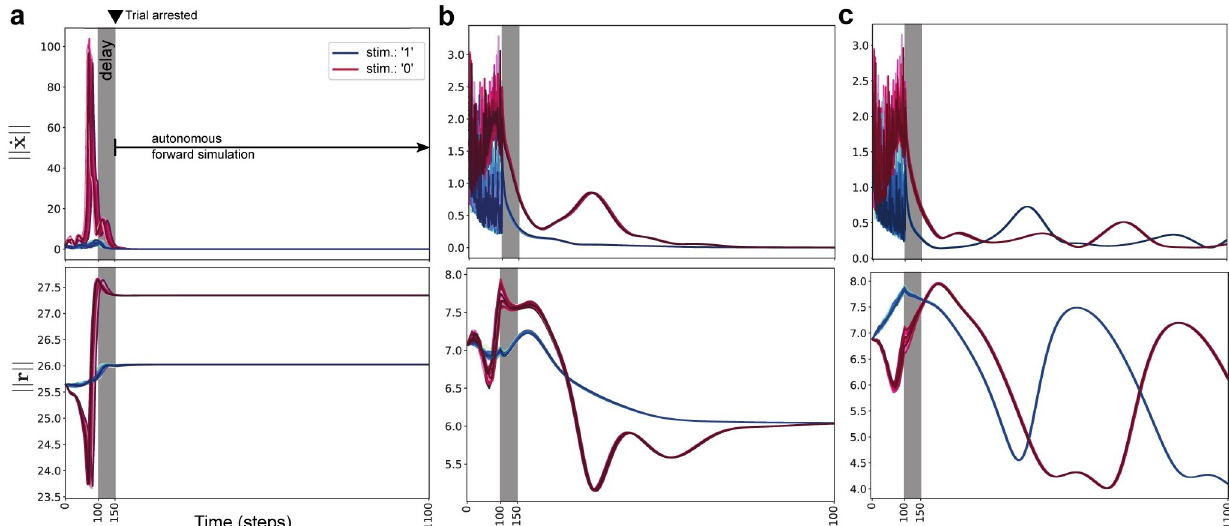
Fig 2. Forward simulation of network after delay to identify distinct dynamical mechanisms underlying WM. a , Direct Fixed Point encoding (DFP), where the network uses fixed points to encode memory representations of each stimulus. b , Indirect Fixed Point encoding (IFP), where the network asymptotically settles at a fixed point but this fixed point does not correspond to a memory representation. c , Limit Cycle (LC), where the network asymptotically approached a stable limit cycle attractor. For all plots, colors in the spectrum of blue show different realizations of first stimulus while colors in the spectrum of red show different realization of second